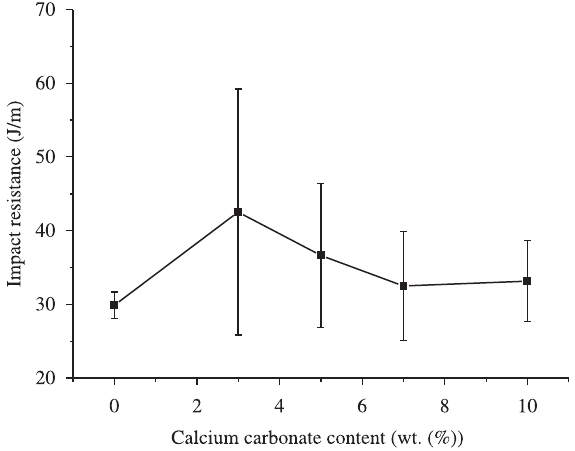
Figure 7. Impact resistance of PP/CaCO CaCO content. 3